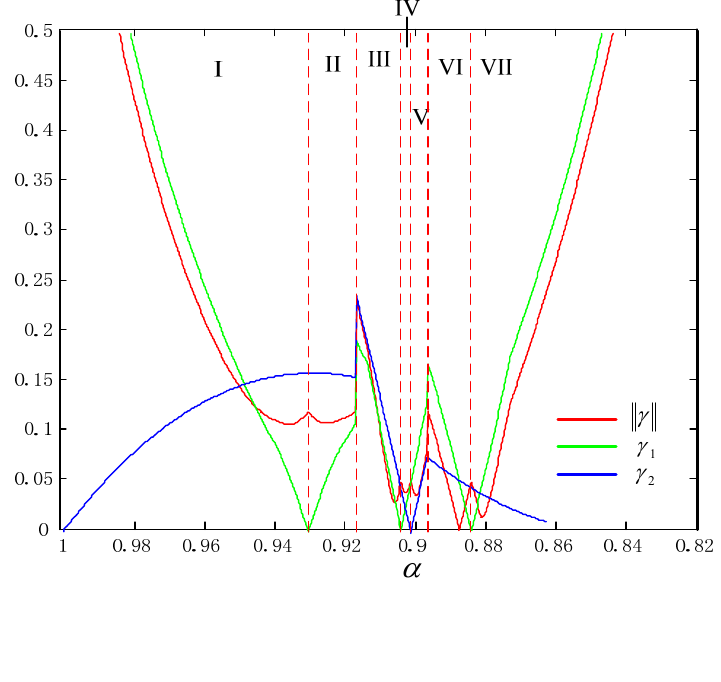
Figure 10. Priority structures and their